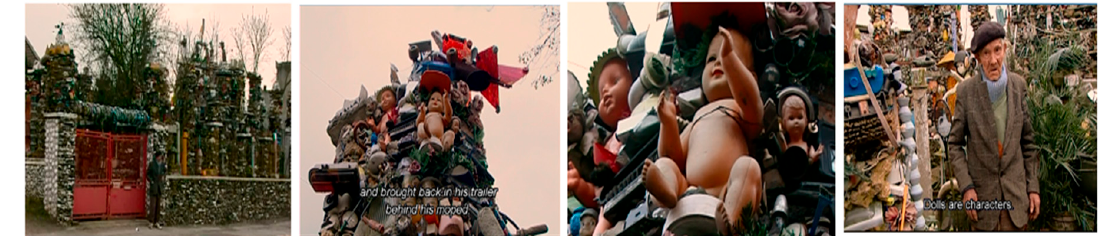
Figure 11. A sample of Varda’s repeated close-ups of Bodan Litnanski’s creations.